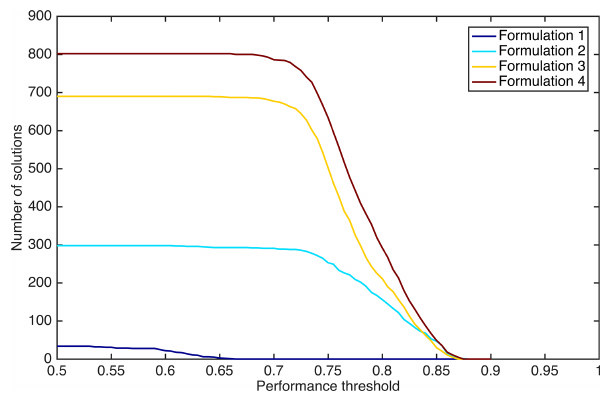
Figure 5. Number of compromise solutions for formulations F1–F4 that exceed increasing performance thresholds in all